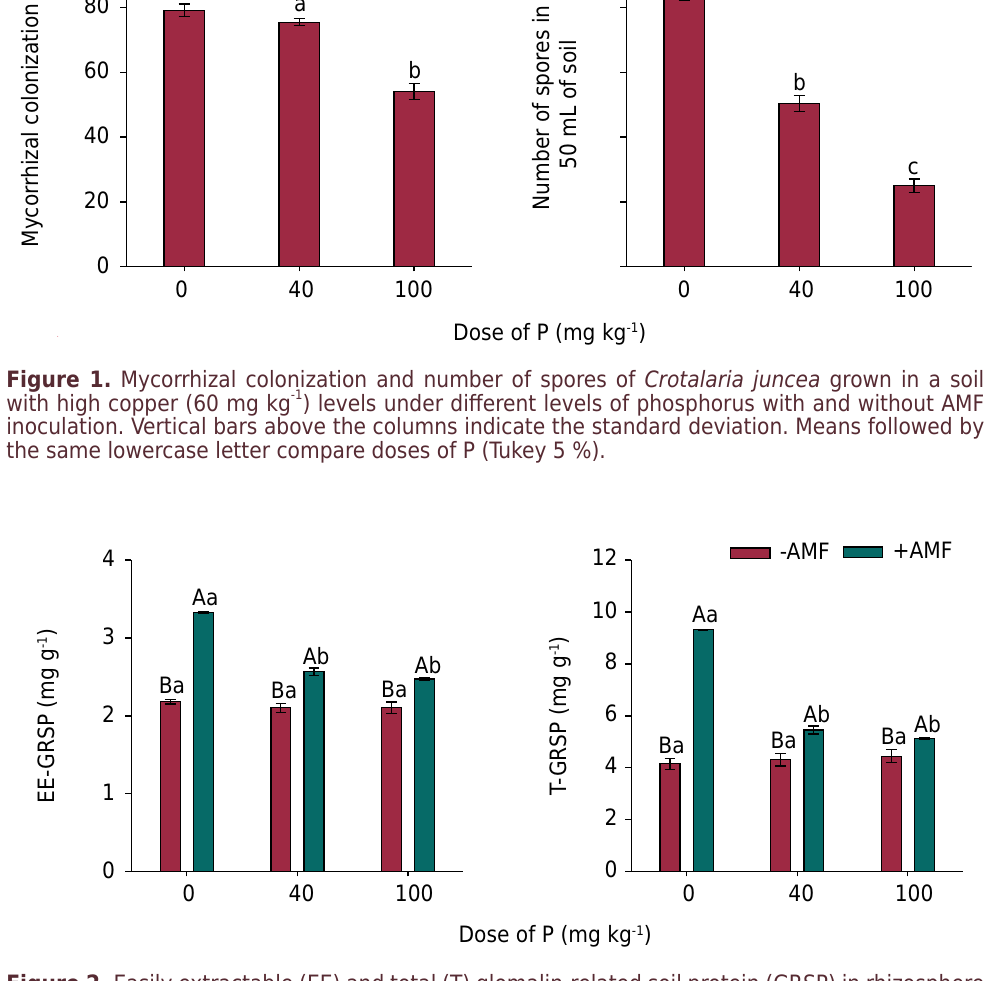
Figure 2. Easily extractable (EE) and total (T) glomalin-related soil protein (GRSP) in rhizosphere soil of Crotalaria juncea plants growing at high copper (60 mg kg -1 ) levels under different levels of phosphorus with and without AMF inoculation. Vertical bars above the columns indicate the standard deviation. Means followed by the same lowercase letter compare doses in the same condition inoculation and uppercase letters compare inoculation within the same dose of P (Tukey 5 %).